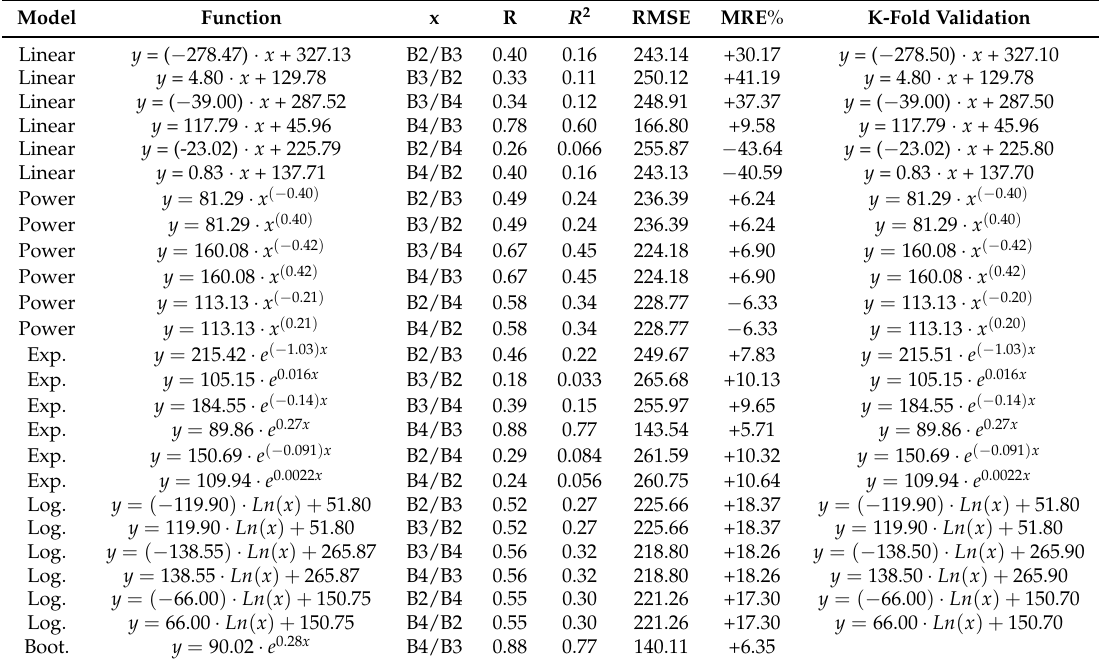
Table 2. The results for algorithm development and K-fold analysis with linear, power, exponential (exp.) and logarithm (log.) models and six band ratio combinations. Exponential function with band ratio B4/B3 was selected based on highest R 2 and low MRE. The last row is the bootstrapping results for the selected exponential algorithm